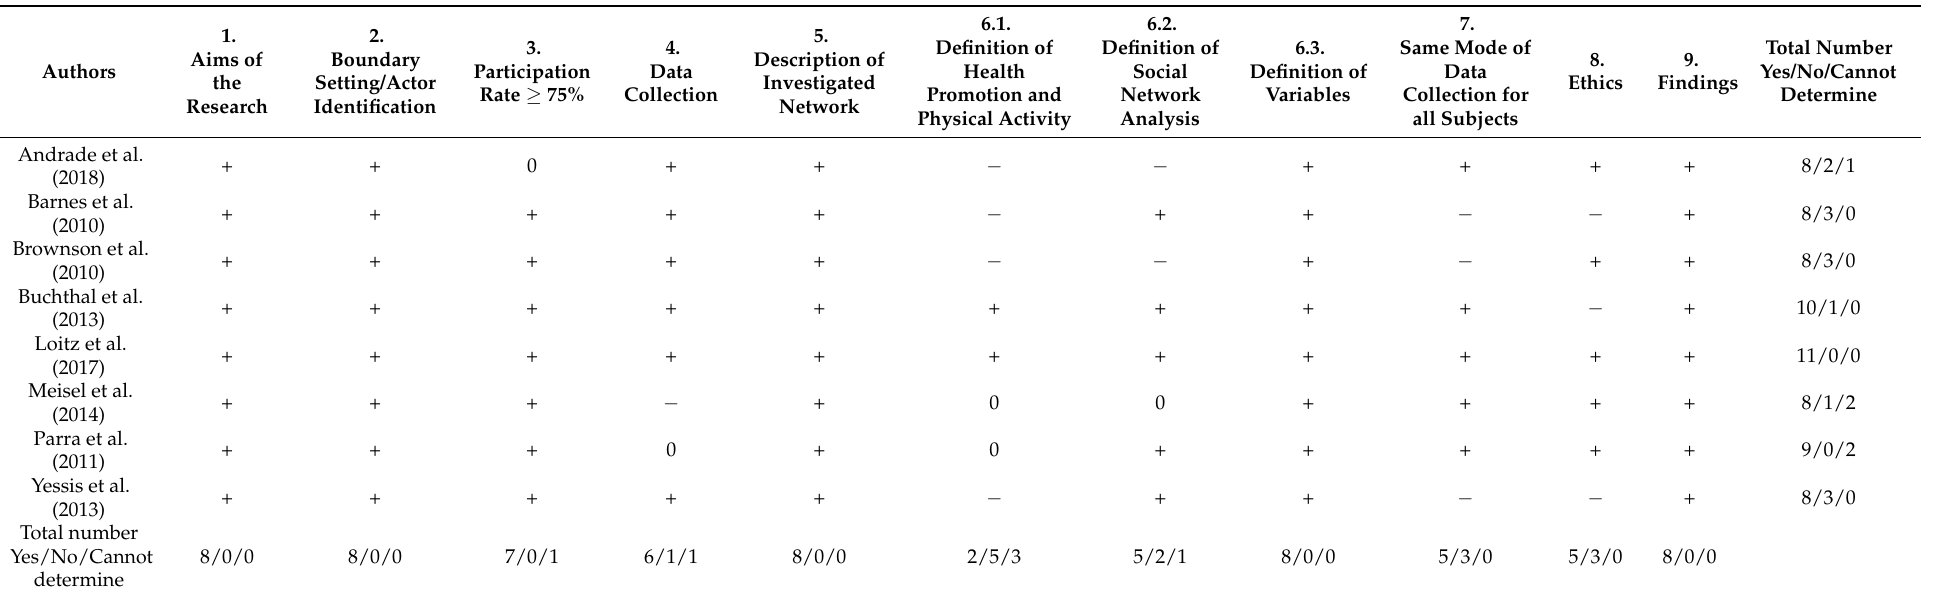
Table 2. Quality assessment for included studies. Yes = +; No = − ; Cannot determine =